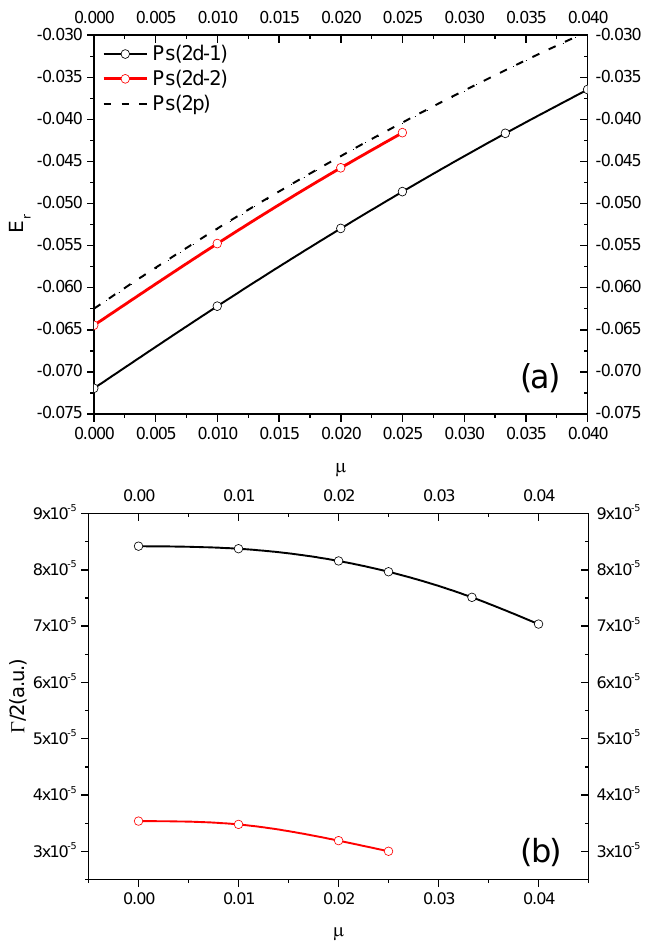
Figure 2. D -wave ( a ) resonance energy and ( b ) half-width for the Ps(2d- k ) states with k = 1 and 2 as a function of μ = 1/ D .